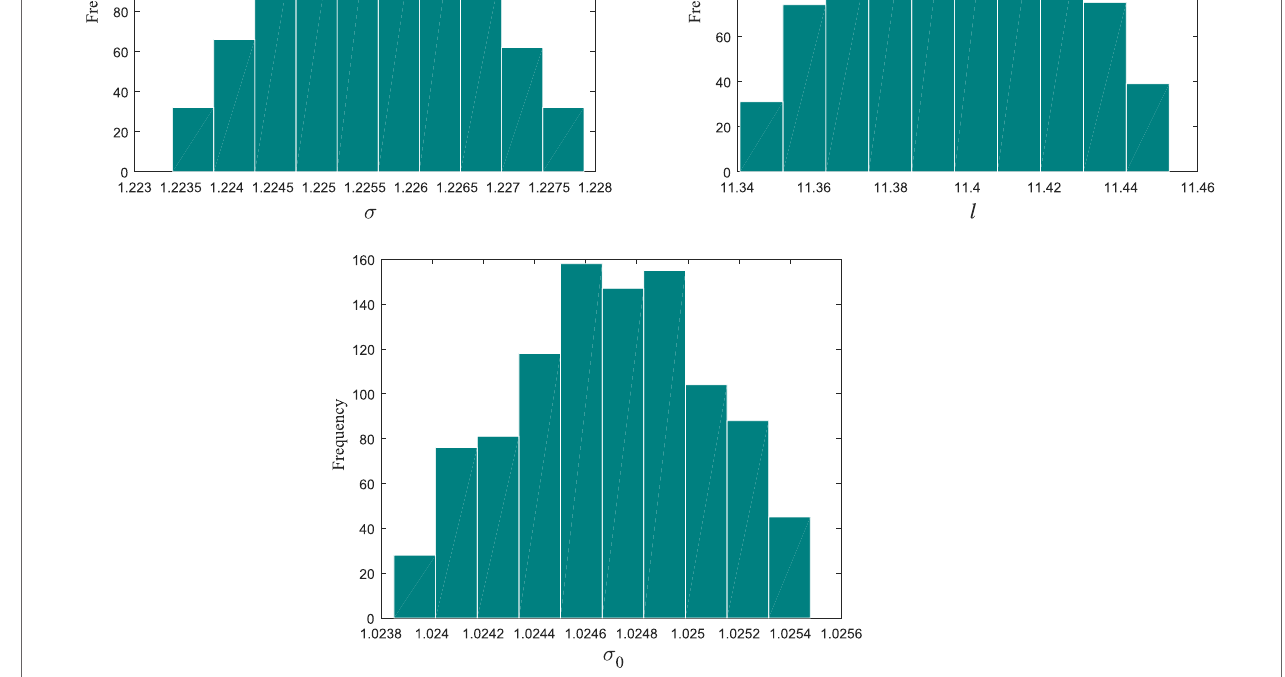
FIGURE 3 | Kernel parameter distributions.